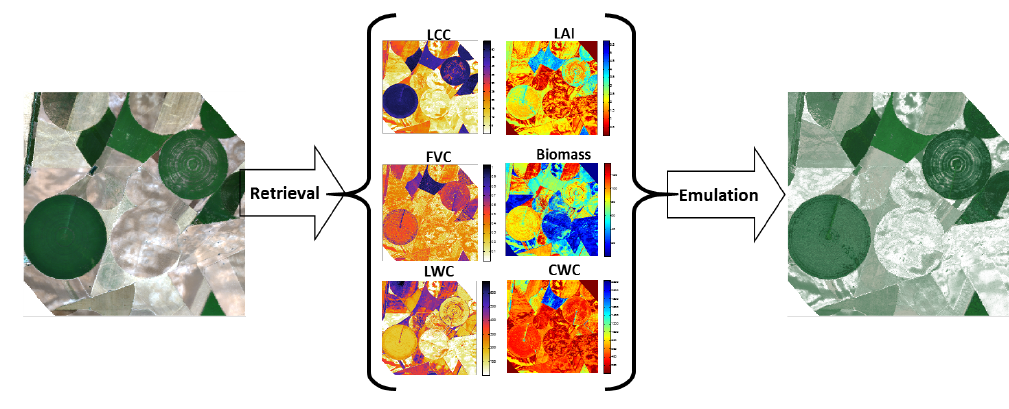
Figure 7. Schematic overview of RGB and emulated synthetic subset of HyMap scene over agricultural